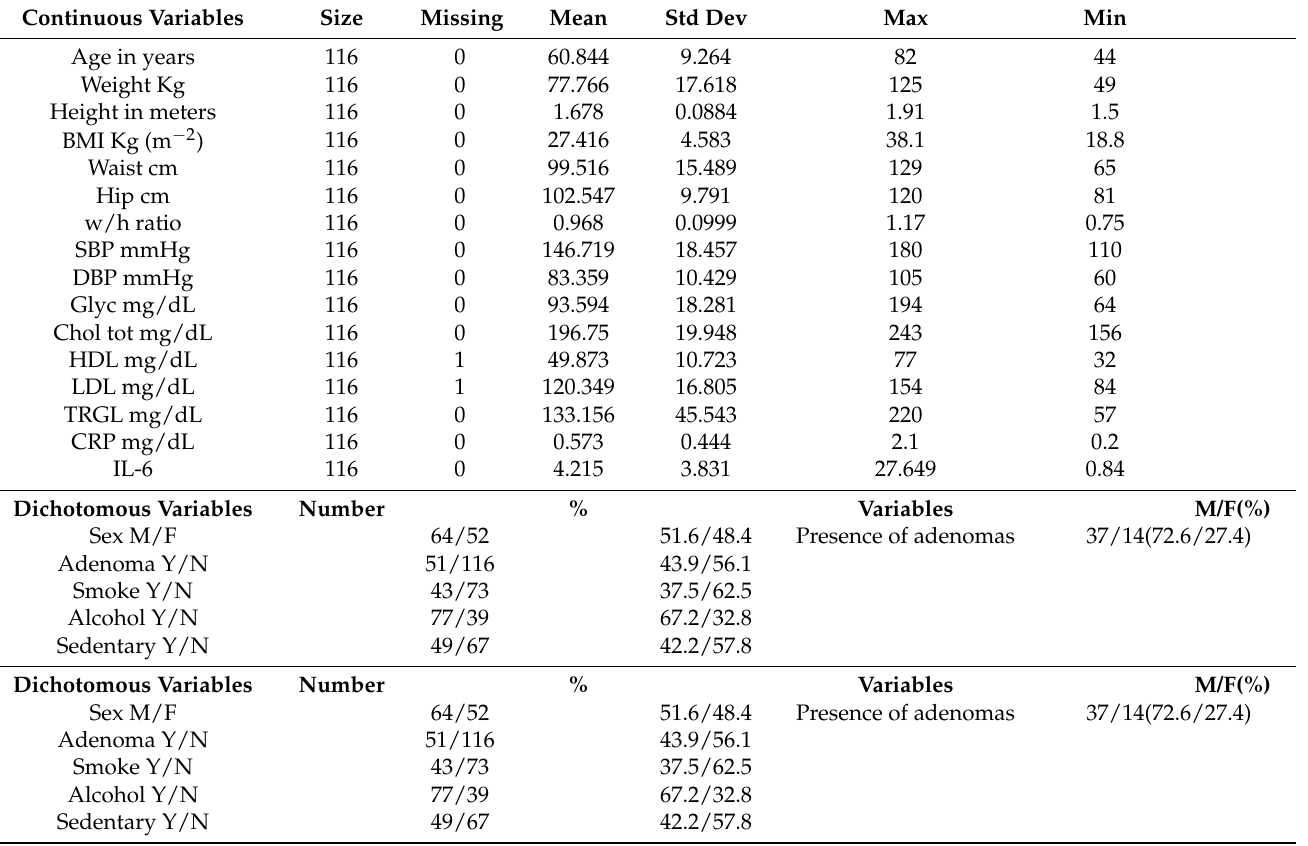
Table 3. Demographic, anthropometric, and clinical variables of the patients enrolled in the